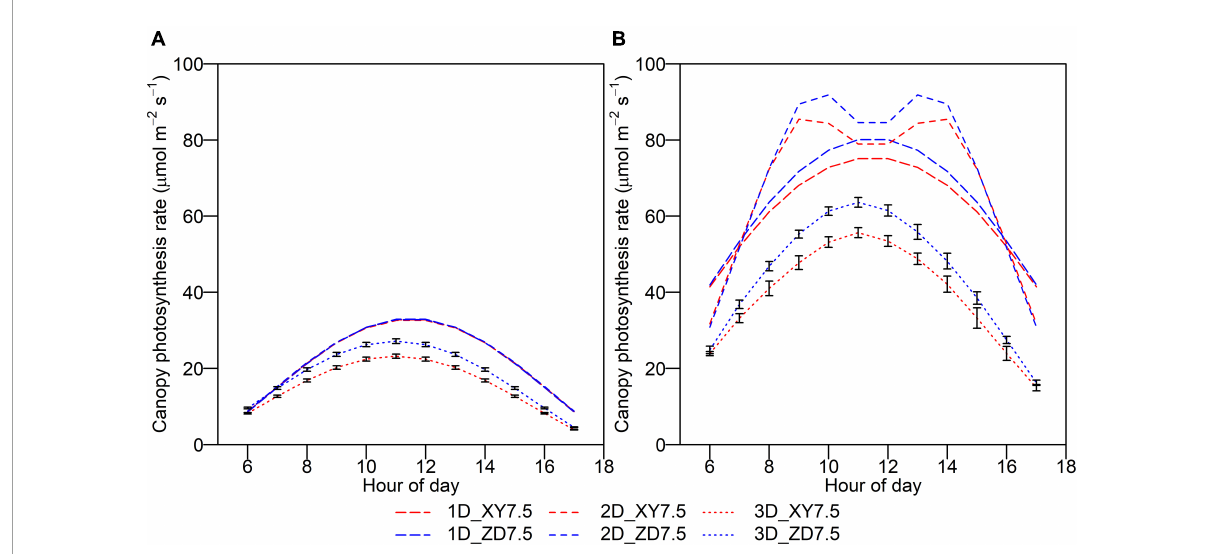
FIGURE7 Daily course of instantaneous canopy photosynthesis rate for ZD958 (blue) and for XY335 at the density of 7.5 plant m - 2 (red) on an overcast day (A) and a clear day (B) by the 1D (longdash lines), 2D (dashed lines), and 3D models (dotted lines). Error bars indicate the SE.